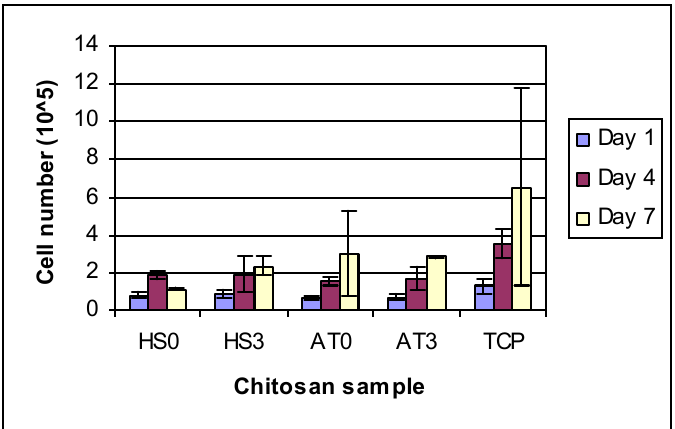
Figure 7. HEPM cell proliferation number on day 1, 4 and 7. Overall 2-way ANOVA: There are differences between days and between groups. TCP was significantly different from all other groups. Each day was significantly different from other